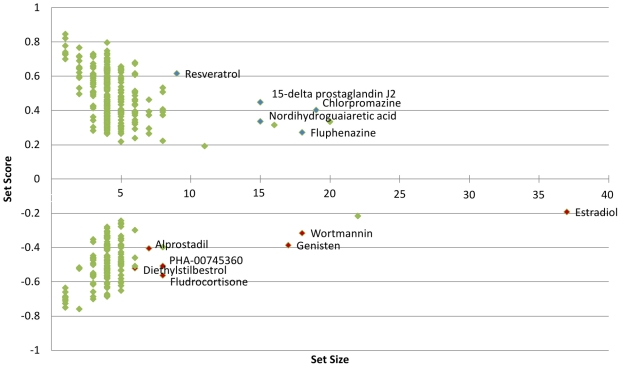
Significant connections to the letrozole treatment signature in breast cancer.Green- significant connections; Blue- significant positive connection setscores with high PS and large setsize; Red- significant negative connection setscores with high PS and large setsize.